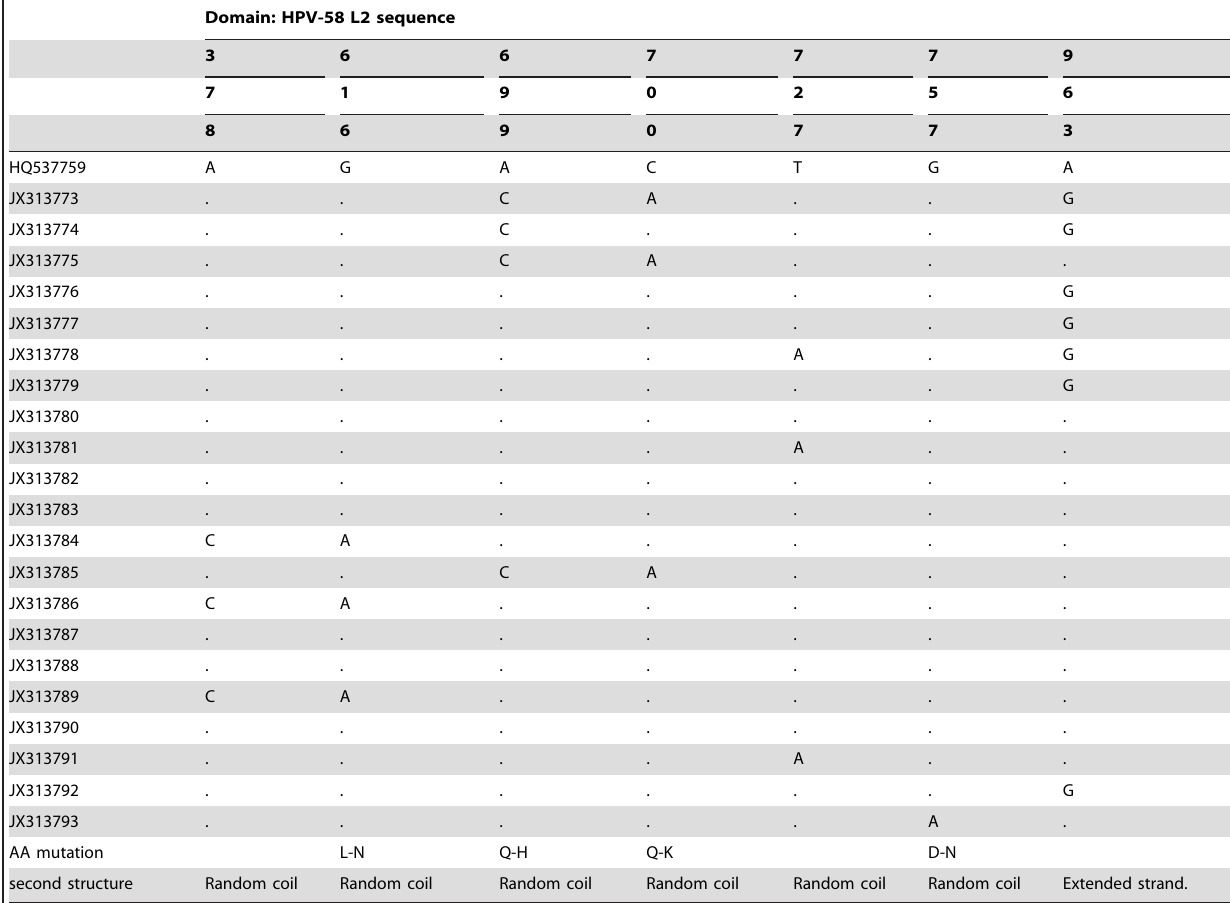
Domain: HPV-58 L2 sequence